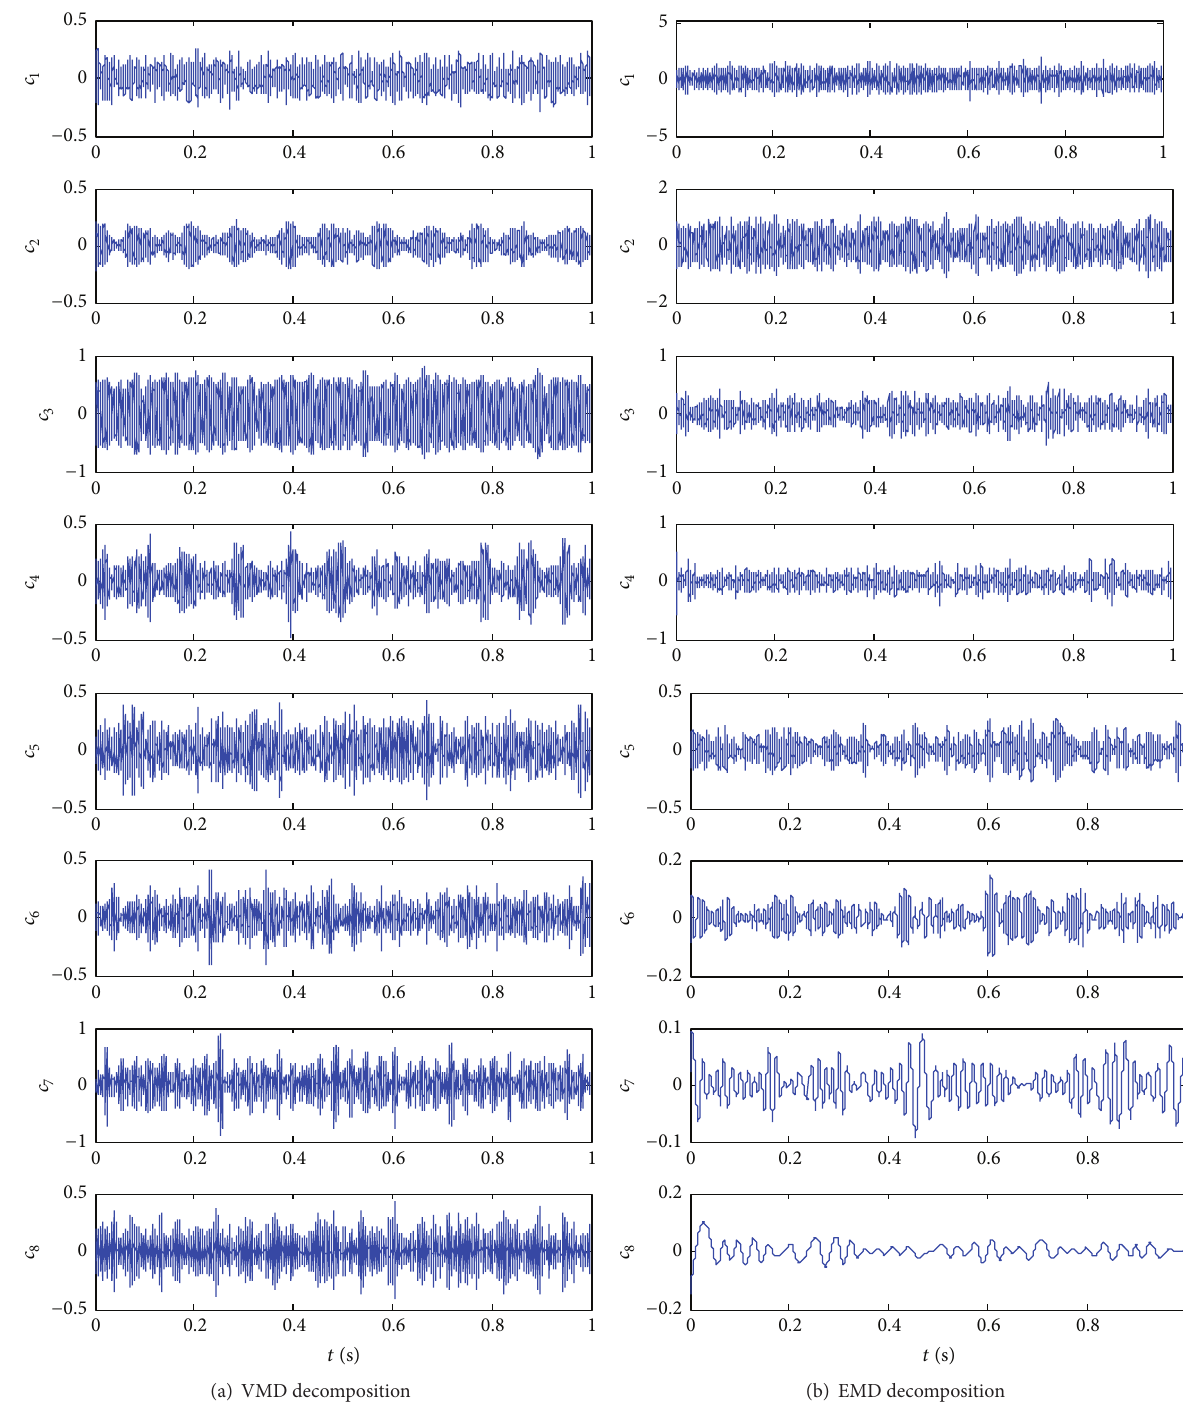
Figure 7: The decomposition results of VMD and EMD for a normal vibration